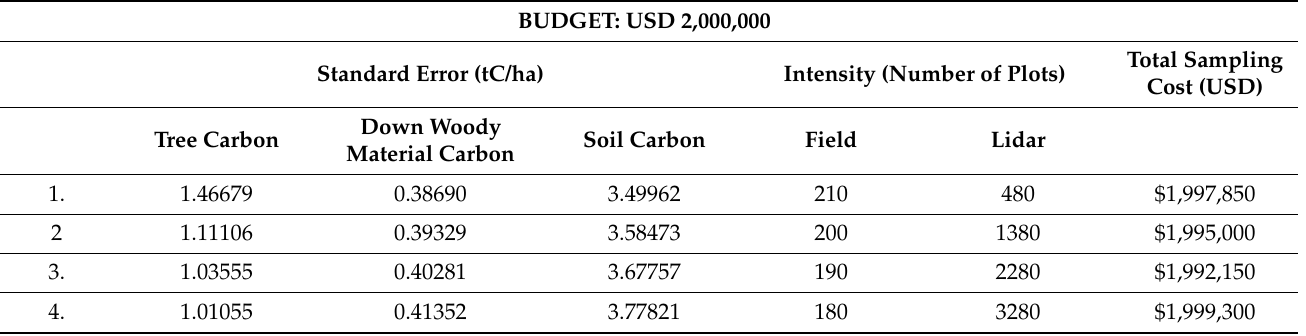
Table 1. Pareto optimal sampling schemes and their associated standard errors using parameter estimates based on observed data with a budget of USD 2,000,000. BUDGET: USD 2,000,000 Total Sampling Intensity (Number of Plots) Cost